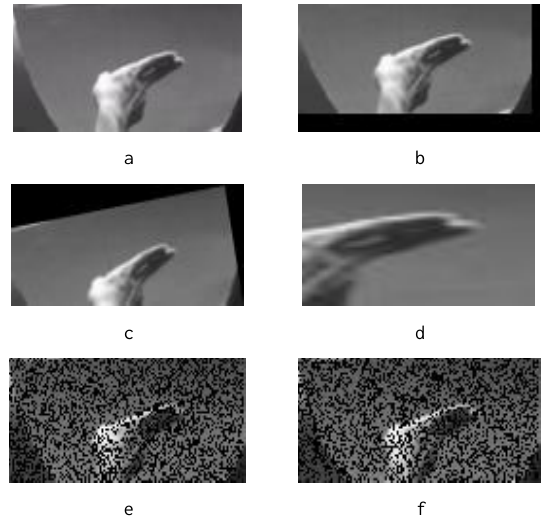
Figure 2. Data augmentation, a) original image, b) translation, c) rotation, d) random crop, e) fixed-pattern drop, and f) random-pattern